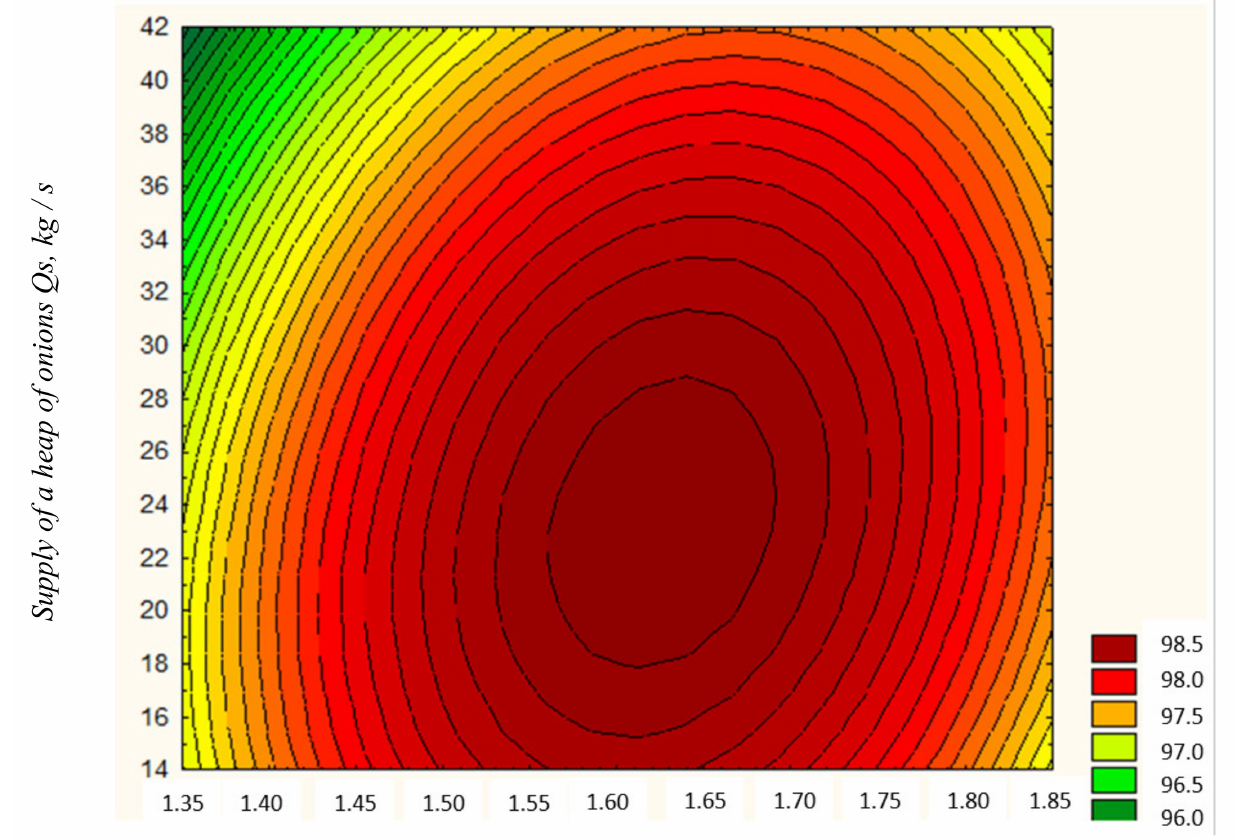
Figure 15. Two-dimensional cross-section of the response surface, characterizing the dependence of the completeness of the separation of the onion pile on the translational speed of the web of the rod elevator (m/s) and the supply of the onion pile